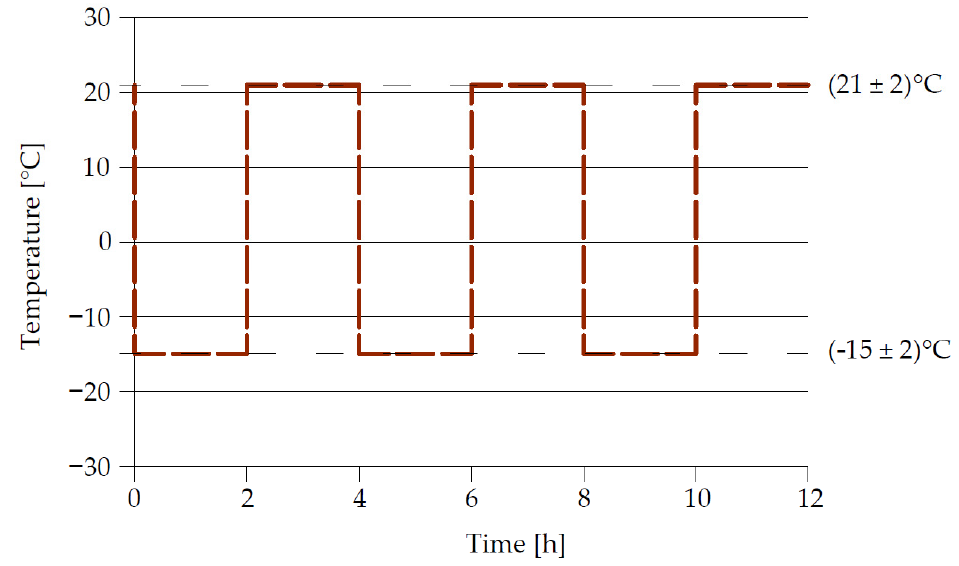
Figure 2. Cycles of freezing in saturated de-icing salt solution and thawing in water, according to [4]. During the test, two specimens are subjected to rapid temperature changes between +21 ± 2 °C and 15 ± 2 °C, including immersion in a saturated, de-icing salt solution, in a special set of test chambers (Figure 3).